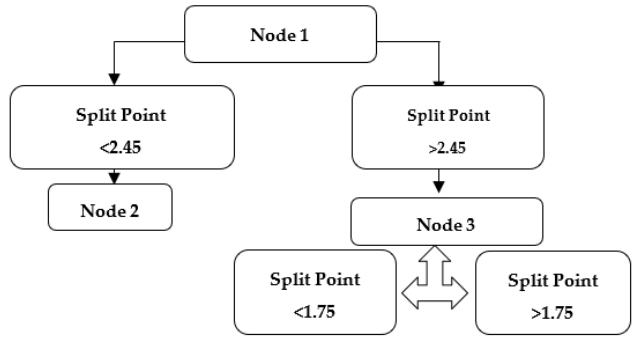
Figure 1. Basic structure of decision tree.